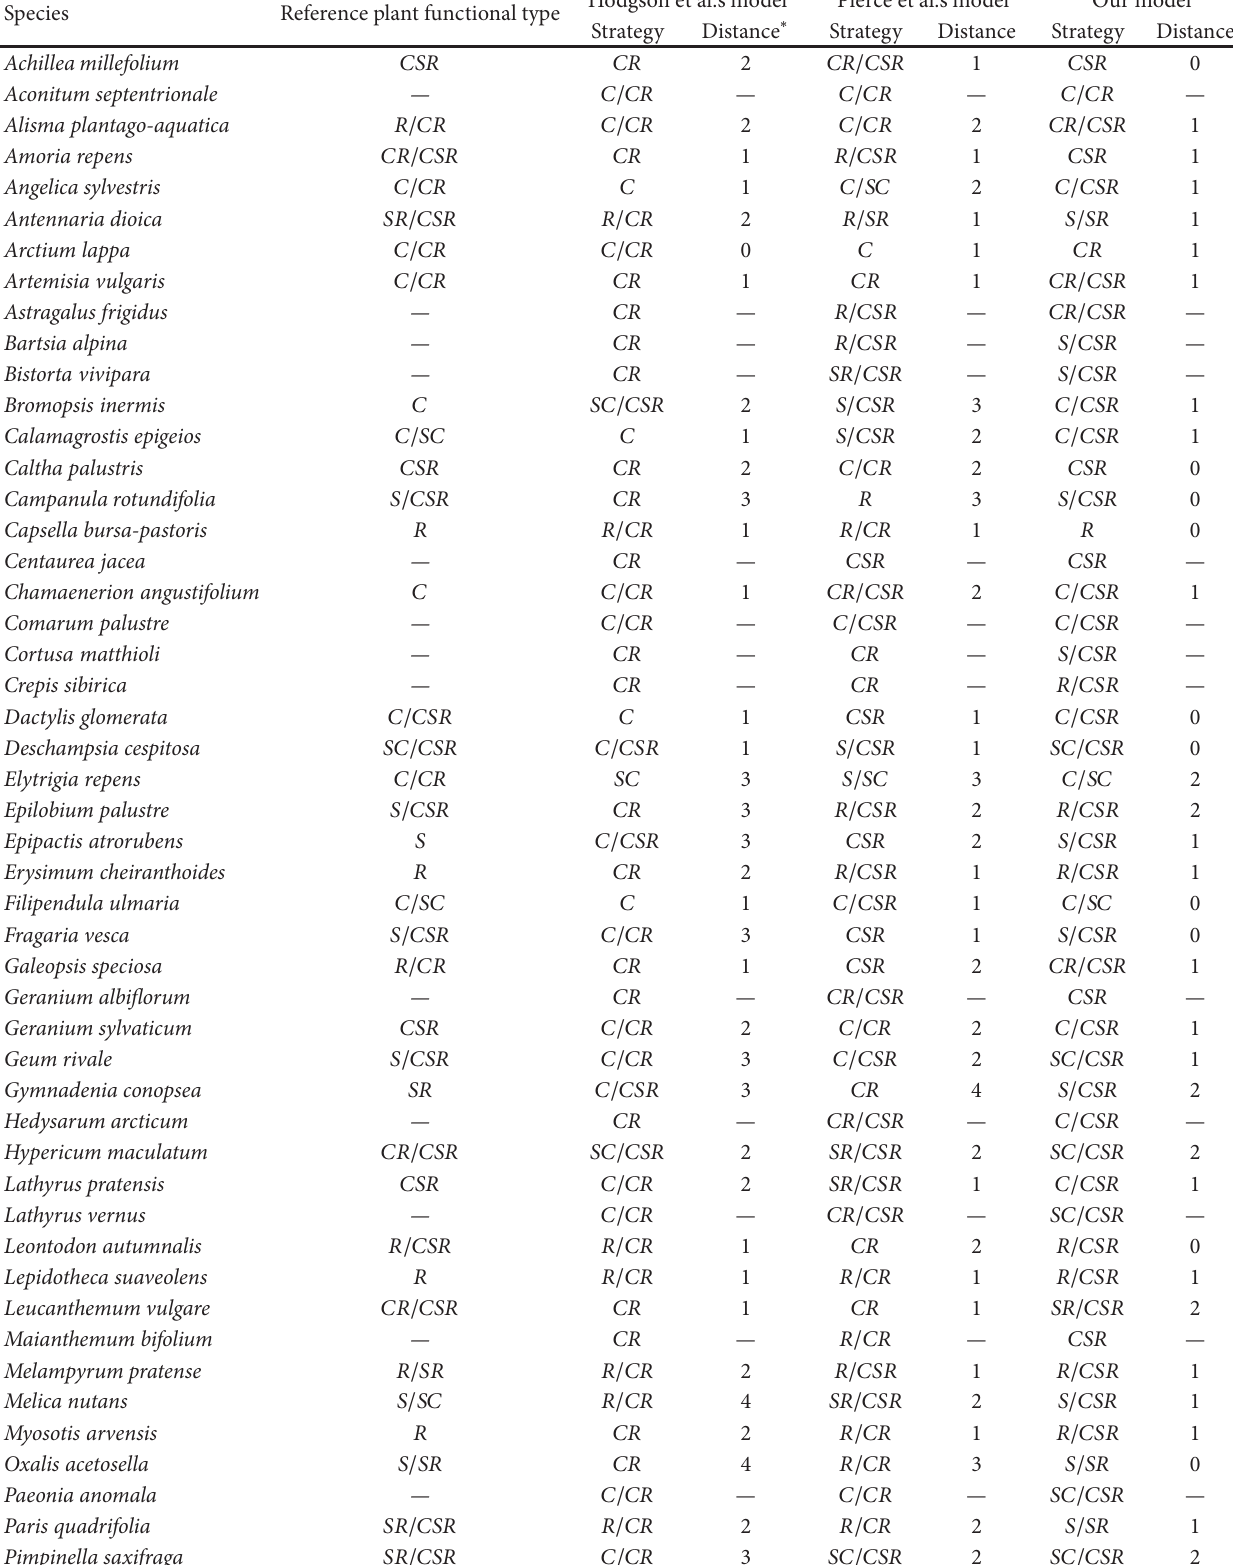
Table 4: Comparison of reference plant functional type [2] and determined by Hodgson et al. [11], Pierce et al. [15], and our model for northern